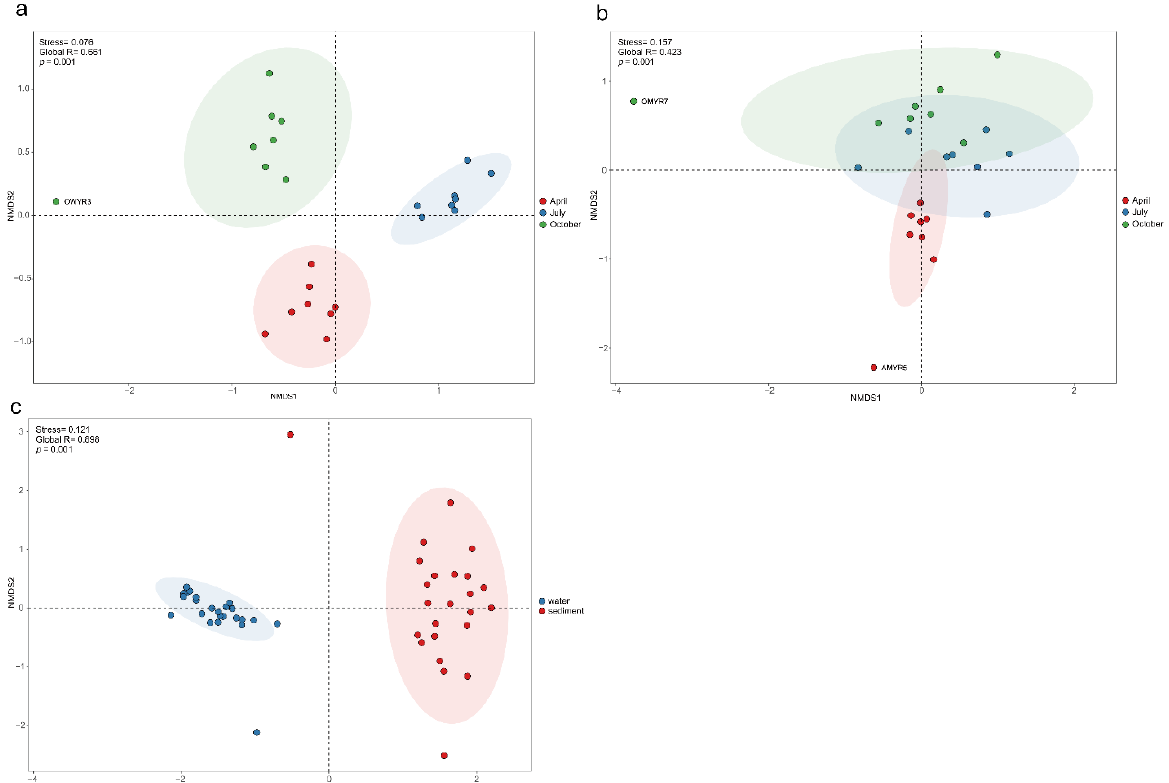
Figure 5. NMDS (Nonmetric multidimensional scaling analysis) and ANOSIM for bacterioplankton communities in sampling periods ( a , b ) and habitats ( c ) on Bray–Curtis similarity. Stress < 0.2 provides a good representation in NMDS. Global R > 0 means the grouping is valid. Moreover, p < 0.05 indicates a significant difference . Ellipses are 95% confidence intervals around the centroid.